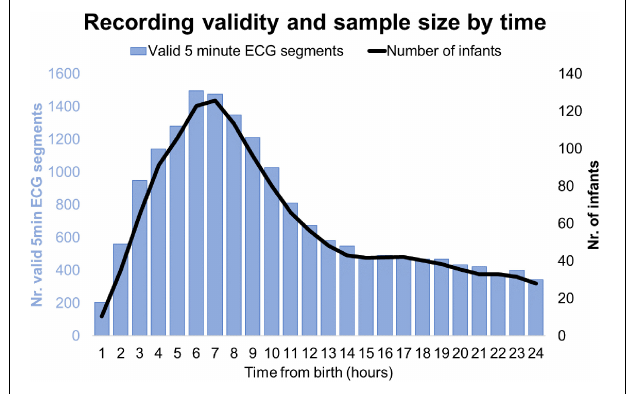
FIGURE 2 | Recording validity and sample size by